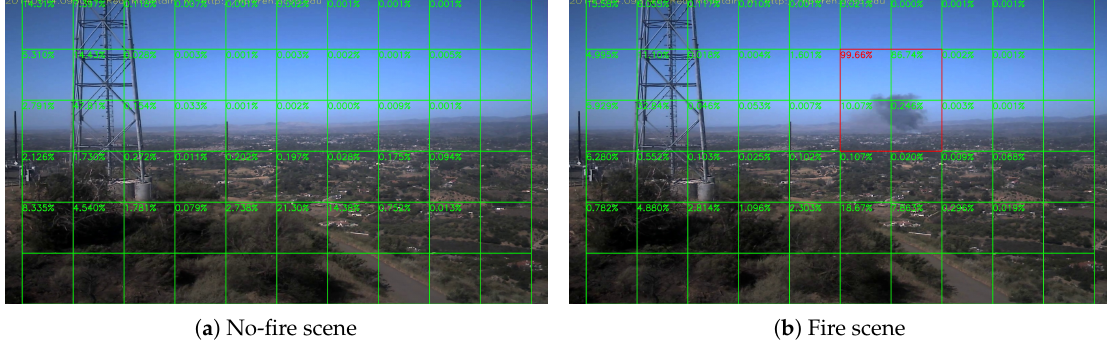
Figure 13. Tomahawk fire, 14 May 2014.